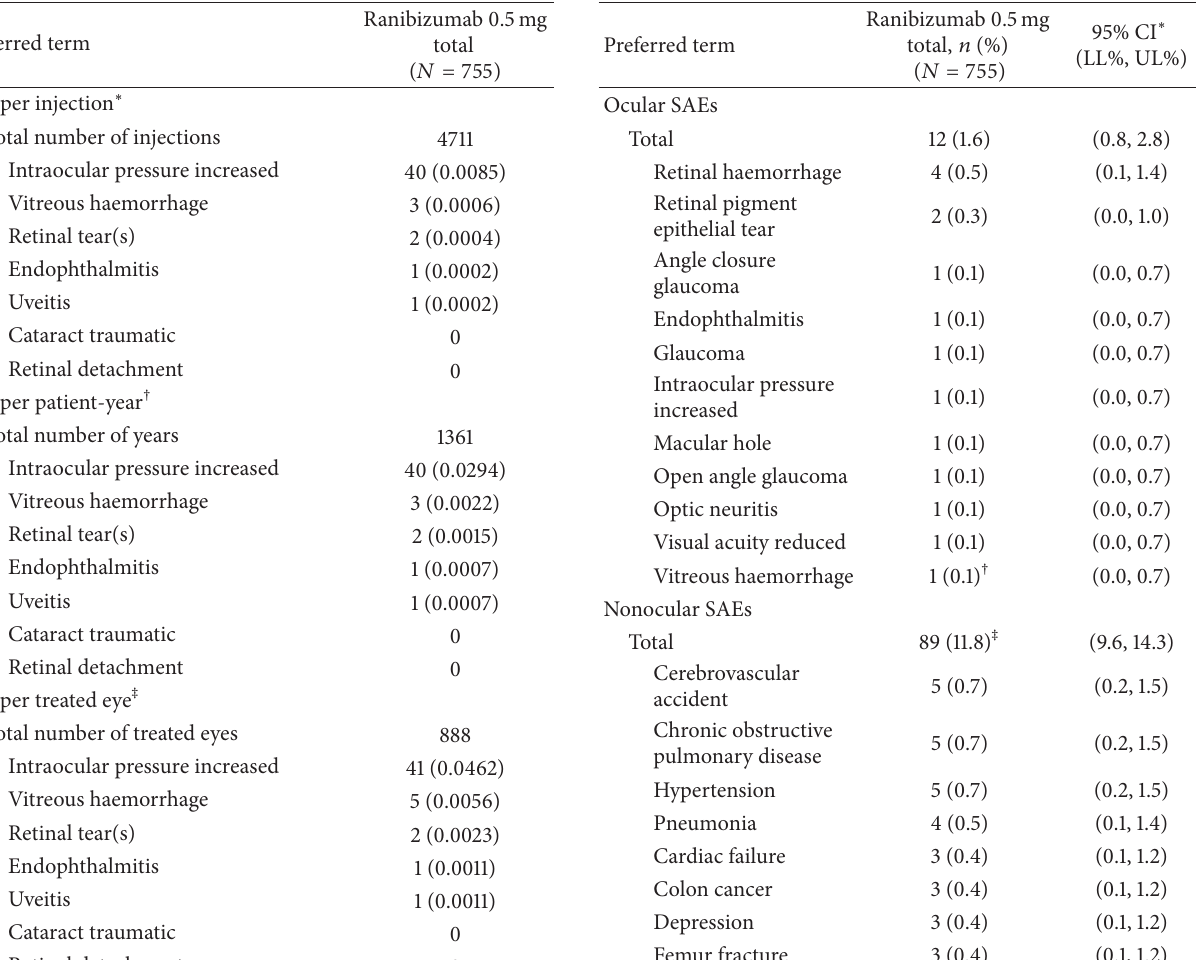
Table 4: Selected AEs over 2 years: per injection, per patient-year (first-treated eye), and per treated eye (safety set).